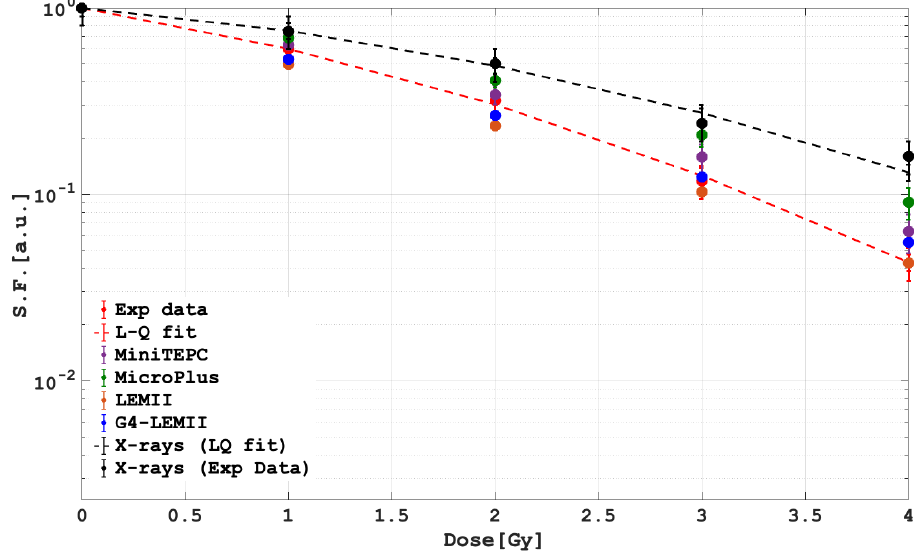
Figure 3. Survival fractions for 92.1. Biological survival data acquired with proton beam irradiations (red symbols) are plotted together with the linear-quadratic best fit (red dashed line). Biological survival data acquired with gamma rays (black symbols) are plotted together with the best fit (black dashed line). The survival fractions predicted from microdosimetric measurements calibrated on gamma-rays cell survival are also plotted. Purple and green points are related to the mini-TEPC and MicroPlus respectively. The blue points were calculated by coupling the Monte Carlo Geant4 with the LEM-II model. Finally, the orange points are obtained with the LEM-II module.